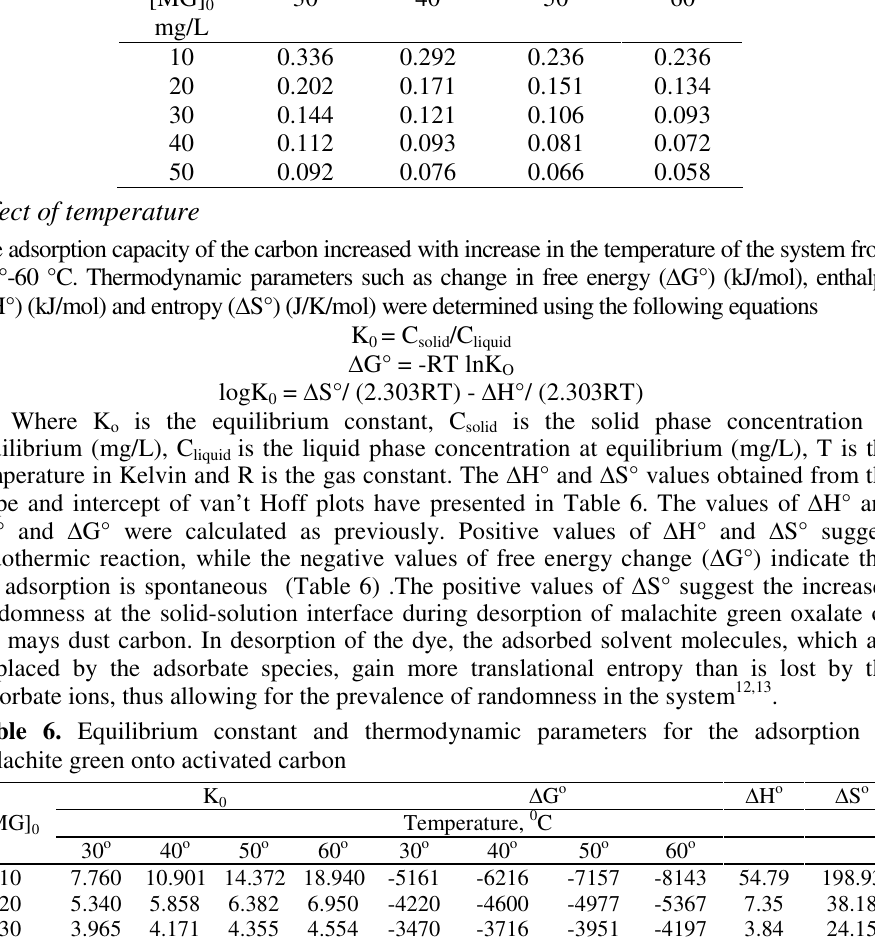
Table 5. Dimensionless separation factor (R